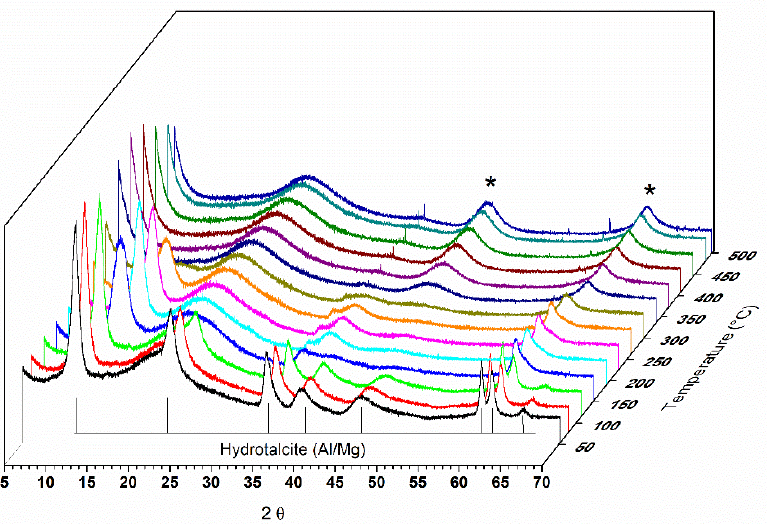
Figure 1. Diffractograms of a sample of lamellar double hydroxide-like materials (LDH) calcined under O 2 flow at 500 °C. (* magnesium oxide).